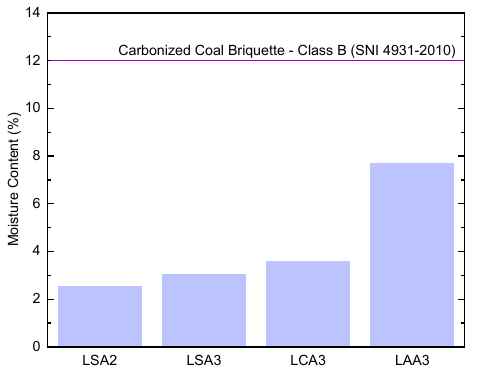
Figure 3. Moisture content of lignin LSA2, LSA3, LCA3, and LAA3 compared to carbonized coal briquette from the SNI 4931–2010 requirement.